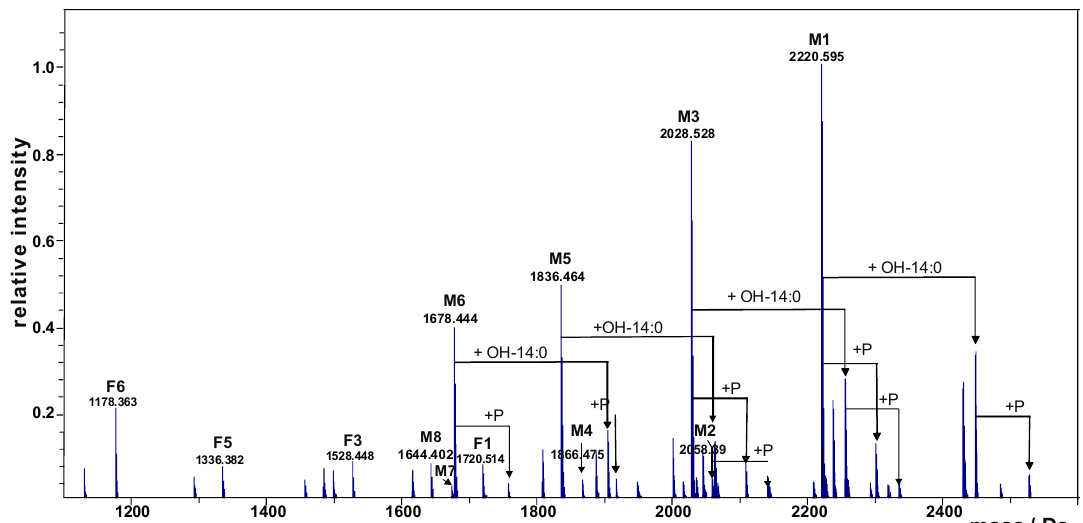
Scheme 1. Structures of the totally deacylated LPS fraction (L-OS KOH ) isolated from the E. amylowora Ea Δ waaL mutant.